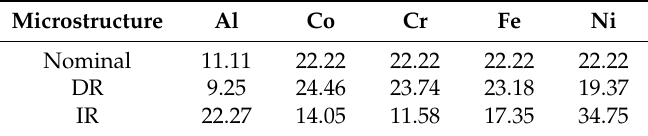
Table 3. Chemical composition of the SLM specimens (at.%).